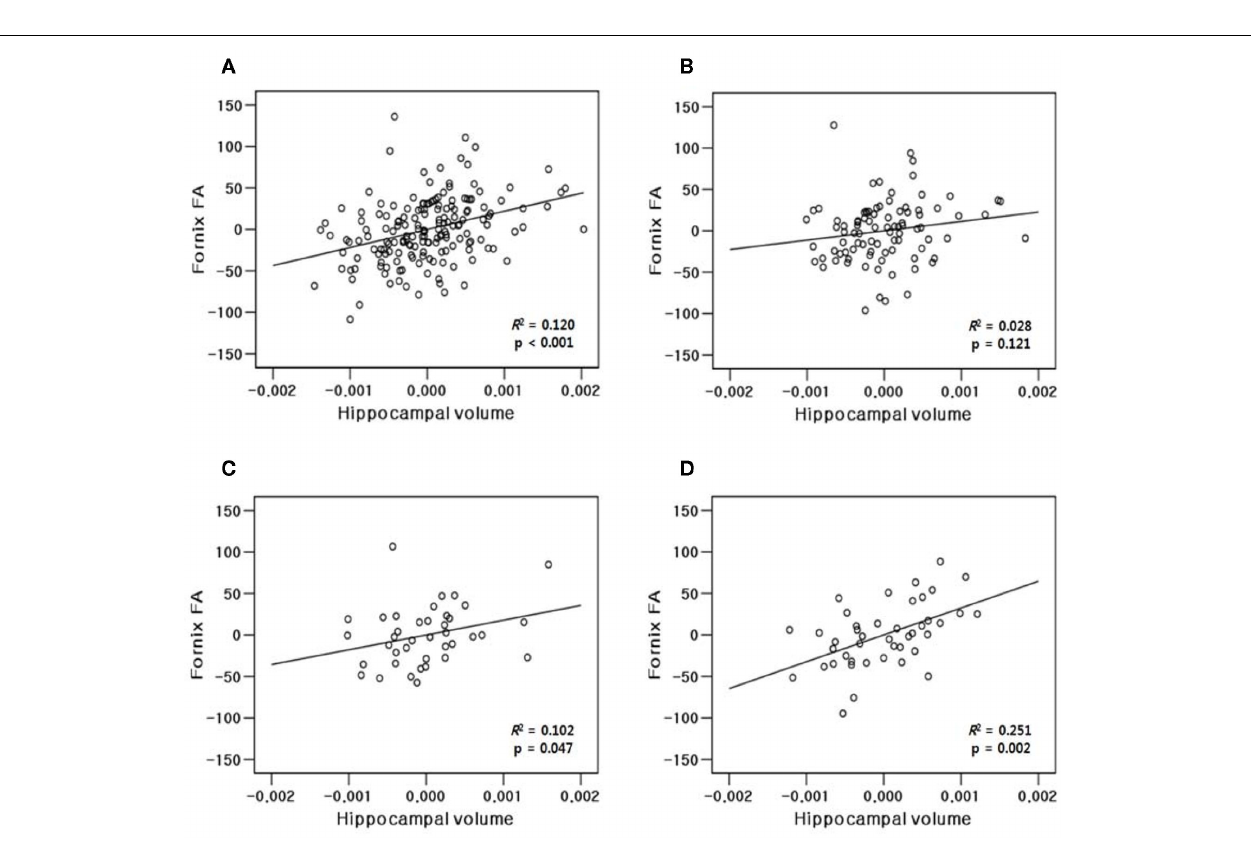
N = 96); (C) mild cognitive impairment (MCI, N = 44); and (D)Alzheimer’s disease (AD, N = 44) group. Variables in each plot were adjusted for age and